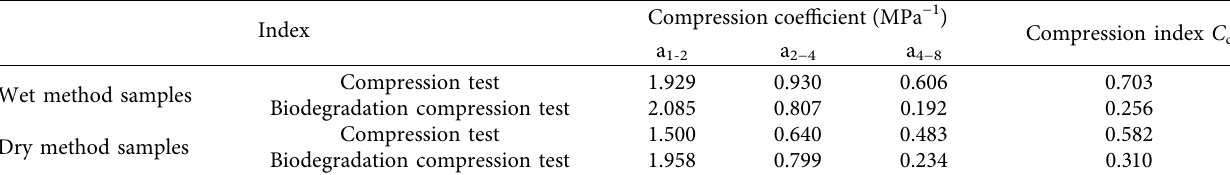
Figure 8: Comparison of average curves between the compression test and the biodegradation compression test. (a) Wet method samples; (b) dry method samples. Table 12: Comparison of parameters between the compression test and the biodegradation compression